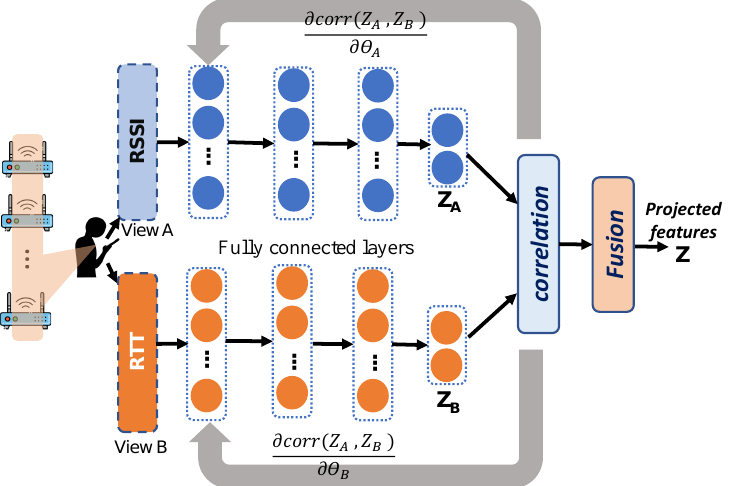
Figure 3. The network structure of the DCCA-based feature extraction module. It consists of two deep networks learned so that the output layers (topmost layer of each network) are maximally correlated. A correlation layer is stacked on top of a fully connected layer to calculate the correlation between the views.